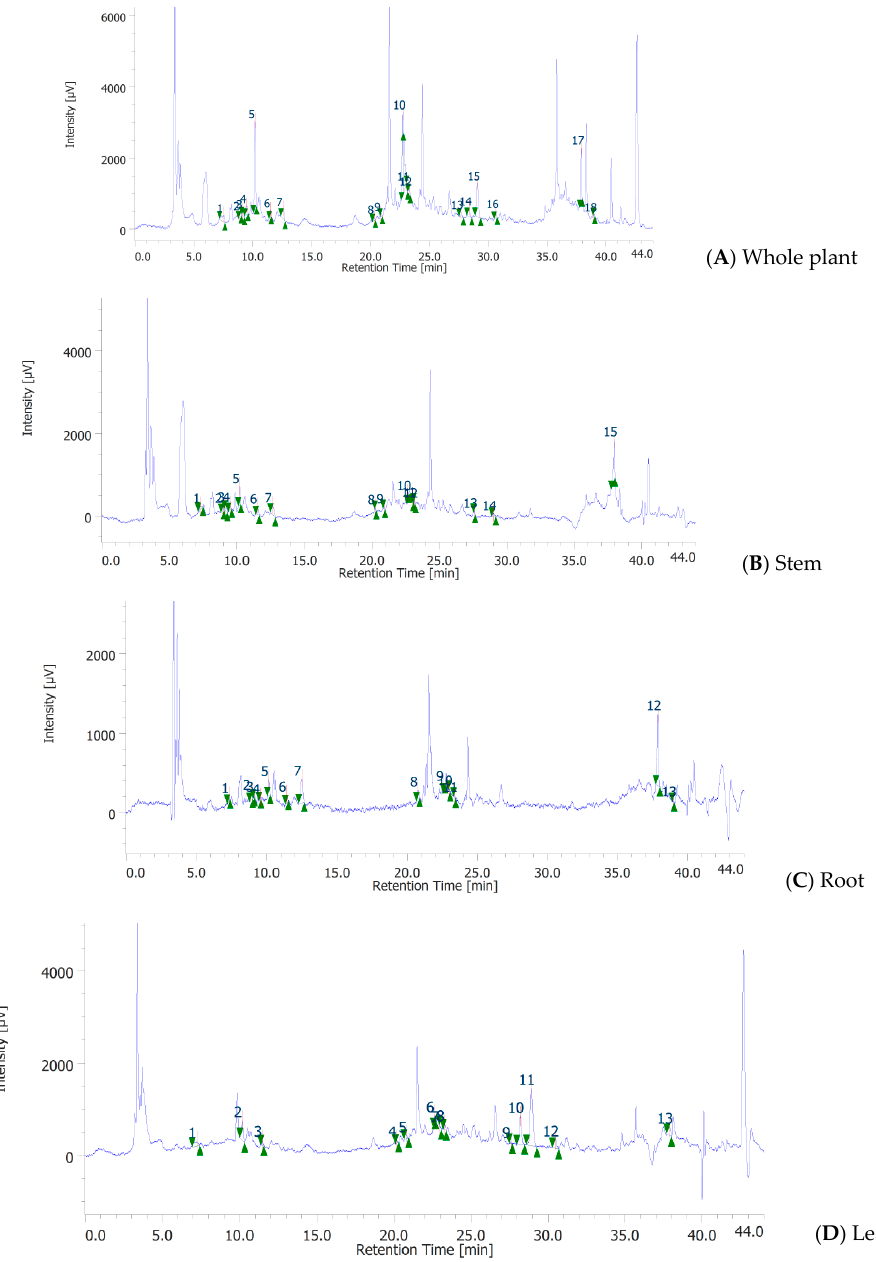
Figure 3. HPLC–DAD-MS analysis of methanolic extracts from B. pilosa plant materials. Among identified phenolic compounds in Table 1, caftaric acid (peak #3), catechin (peak #4), chlorogenic acid (peak #5) and epicatechin (peak #6) were identified in the whole plant ( A ), stem ( B ) and root ( C ). In the leaf ( D ), the principal phenolics identified in the extract were: gallic acid (peak #1), chlorogenic acid (peak #2) and epicatechin (peak #3).